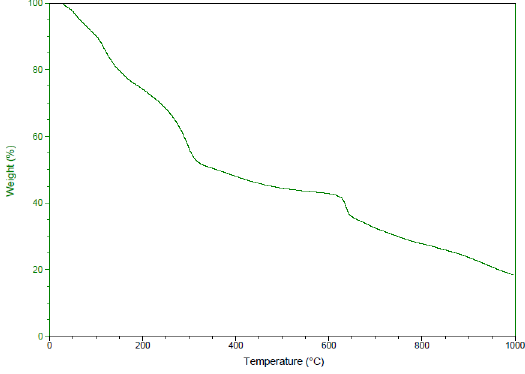
Figure 6. Thermogravimetric analysis (TGA) of silver nanoparticles.